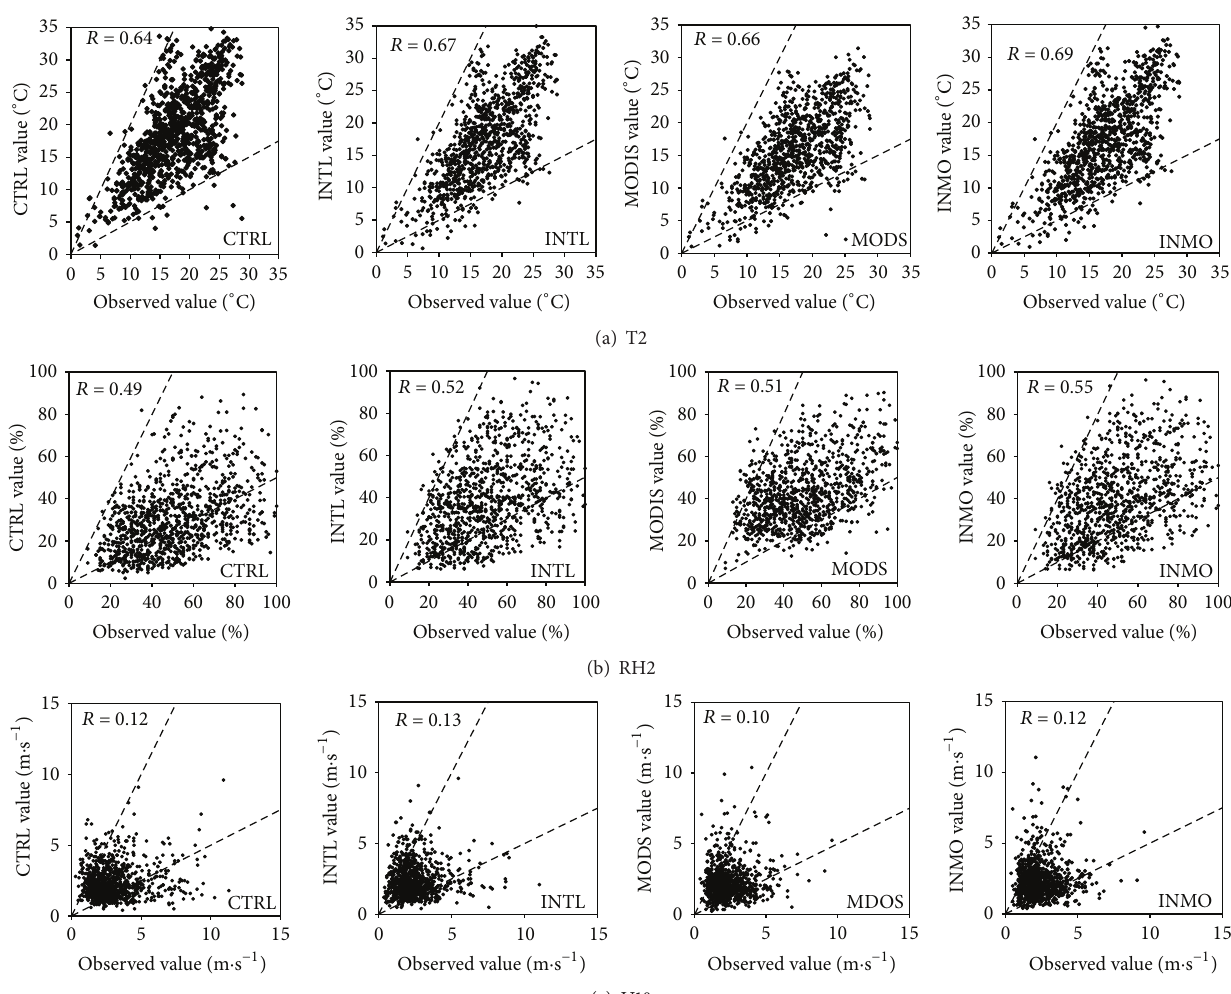
Figure 2: Scatter distribution between observed and modeled near-surface meteorological fields: (a) 2 m temperature (T2), (b) 2 m relative humidity (RH2), and (c) 10m wind speed and (U10). The 1:2 and 2:1 reference lines are